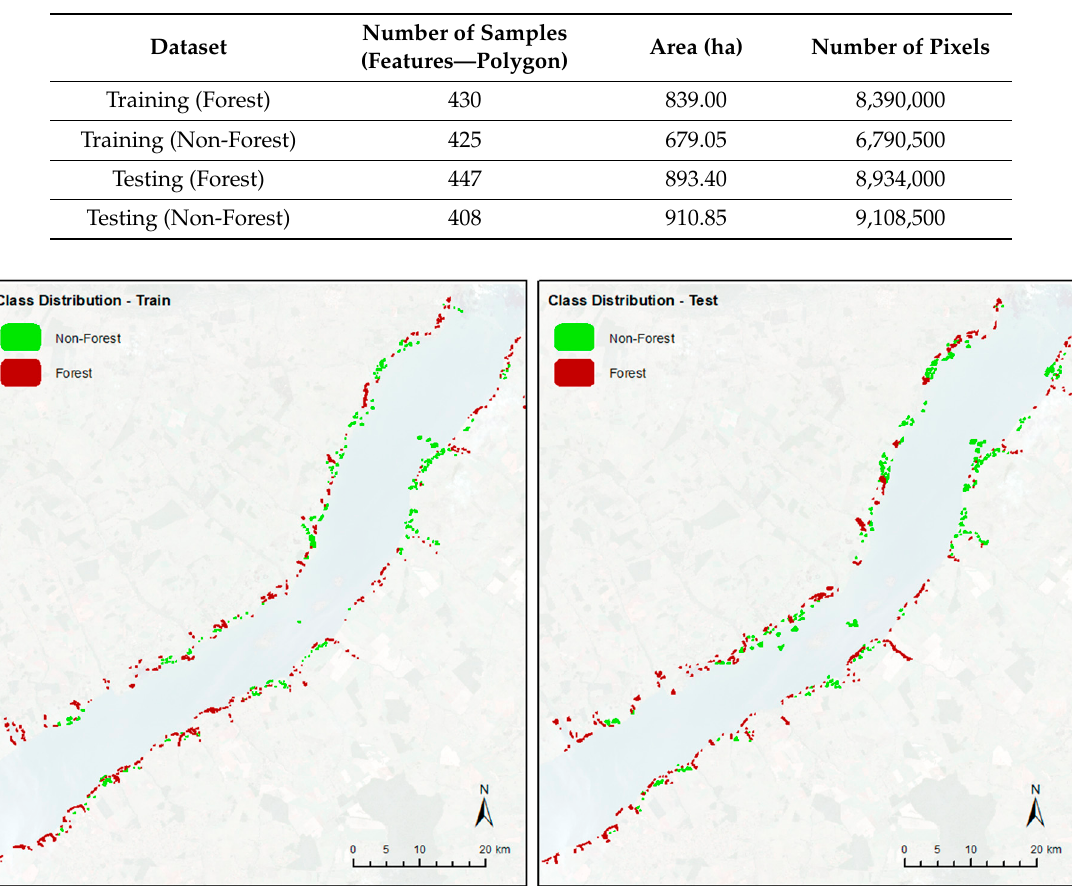
Figure 3. Spatial distribution of the complete dataset used in the Parana river area exemplifying the different